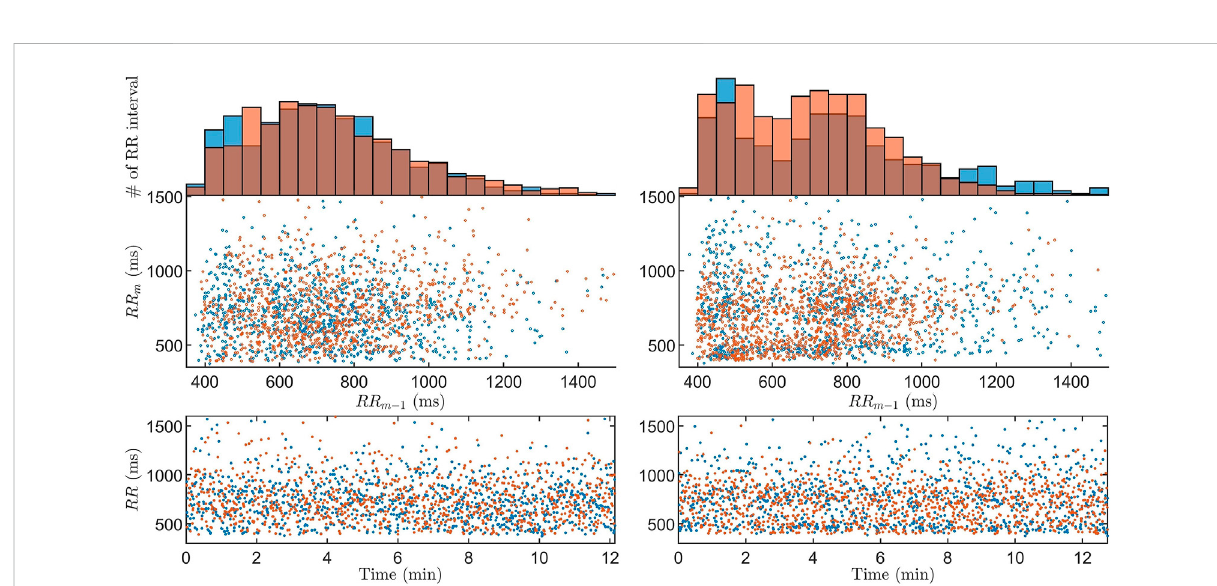
FIGURE 4 The Poincaré plot with associated histogram and RR interval series of data (blue) and model output (orange) for the ^ θ ( i ) corresponding to the median ϵ (left) and to the ^ θ ( i ) which ϵ is higher than 95% of all ϵ (right).